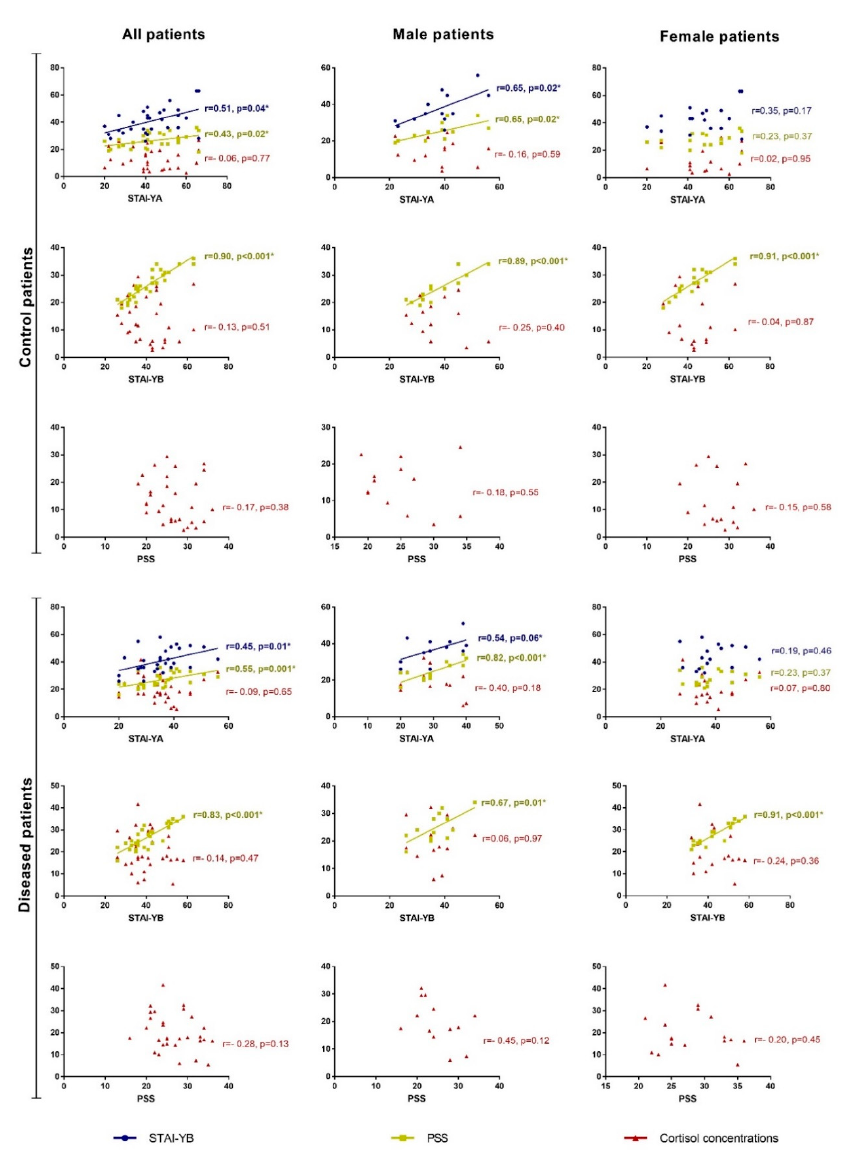
Figure 1. Correlations between questionnaires scores and cortisol concentrations. STAI-YA: State anxiety inventory; STAI-YB: Trait anxiety inventory; PSS: Perceived Stress Scale; r = Rho (correlation coefficient). Correlations between scores of STAI-YA, STAI-YB, PSS and cortisol concentration were analyzed among the control and diseased patients’ groups, in all patients and among men and women of each group. Pearson correlation coefficients and significance are given facing of each tested correlation. The significant correlations have been highlighted with a star.